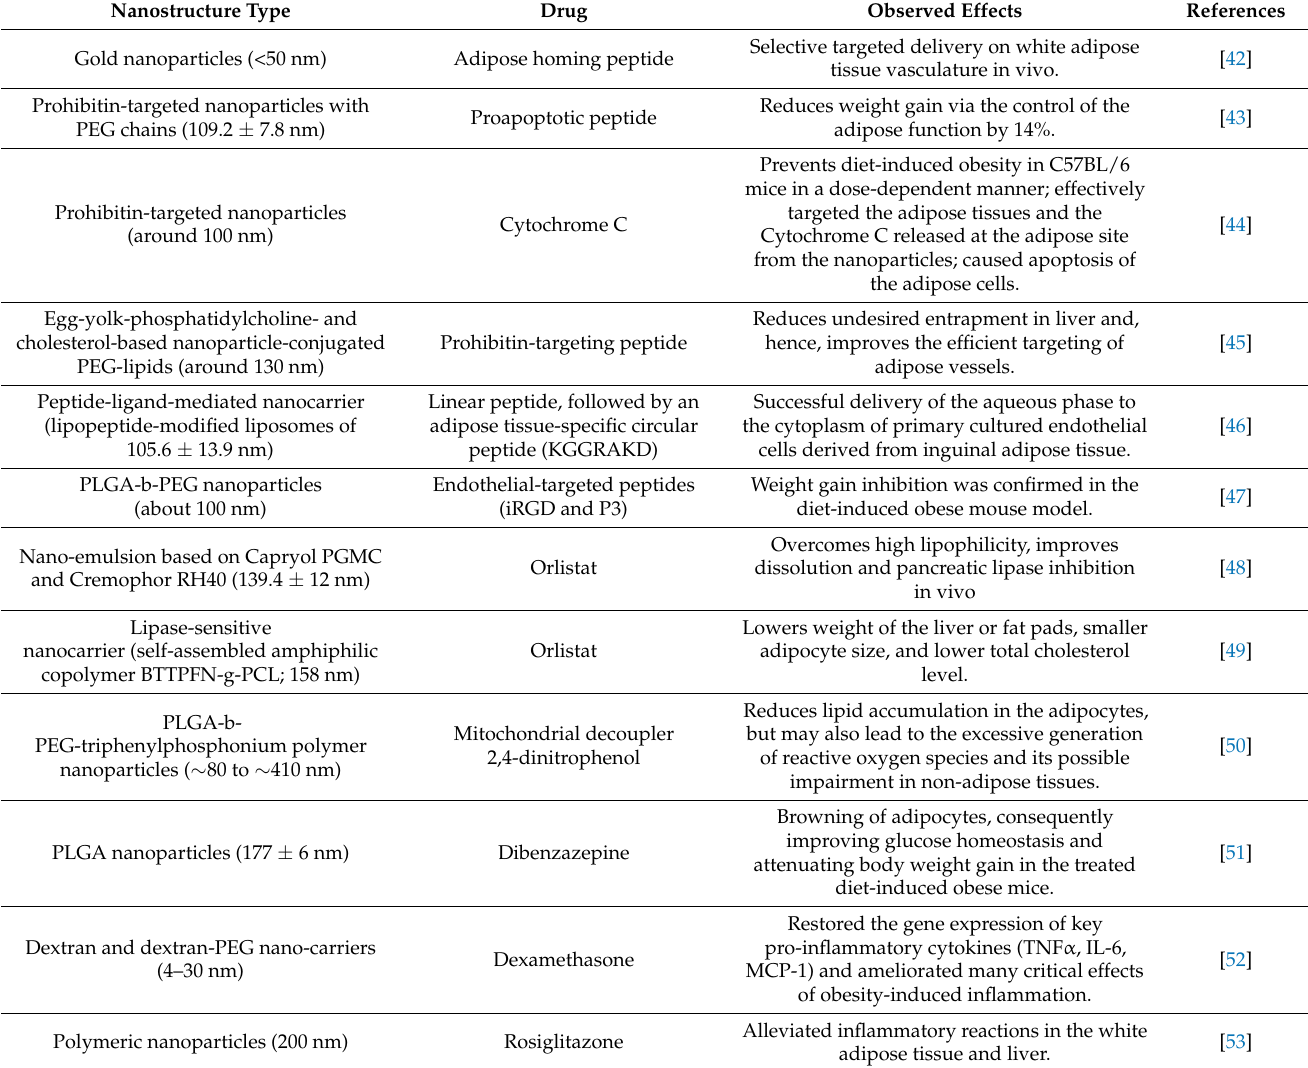
Table 2. Drug-based nanostructures and their therapeutic roles in the management of